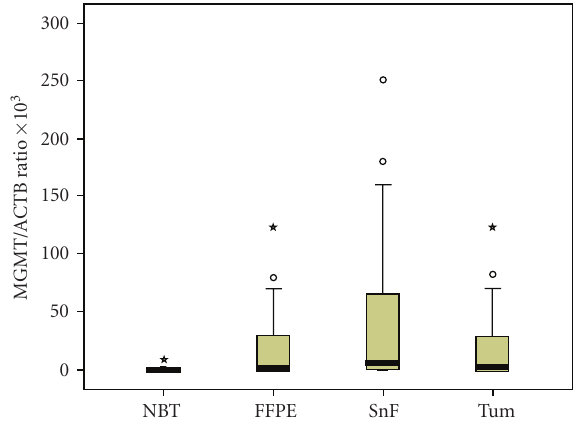
Figure 1: Box plot for the MGMT/ACTB ratios determined by Quantitative Methylatiom Specific PCR in normal brain tissues and tumour samples . NBT: Normal brain tissues ( n = 28); FFPE: Formalin fixed para ffi n-embedded samples ( n = 28); SnF: Snap- frozen specimens ( n = 22); Tum: Total tumour samples ( n = 50). The boxes mark the interquartile range, (interval between the 25th and 75th percentile). The lines inside the boxes denote median values. The whiskers represent the interval between the 10th and 90th percentiles. ∗ indicates the extreme cases with more than three boxes length upper or down from the interquartile